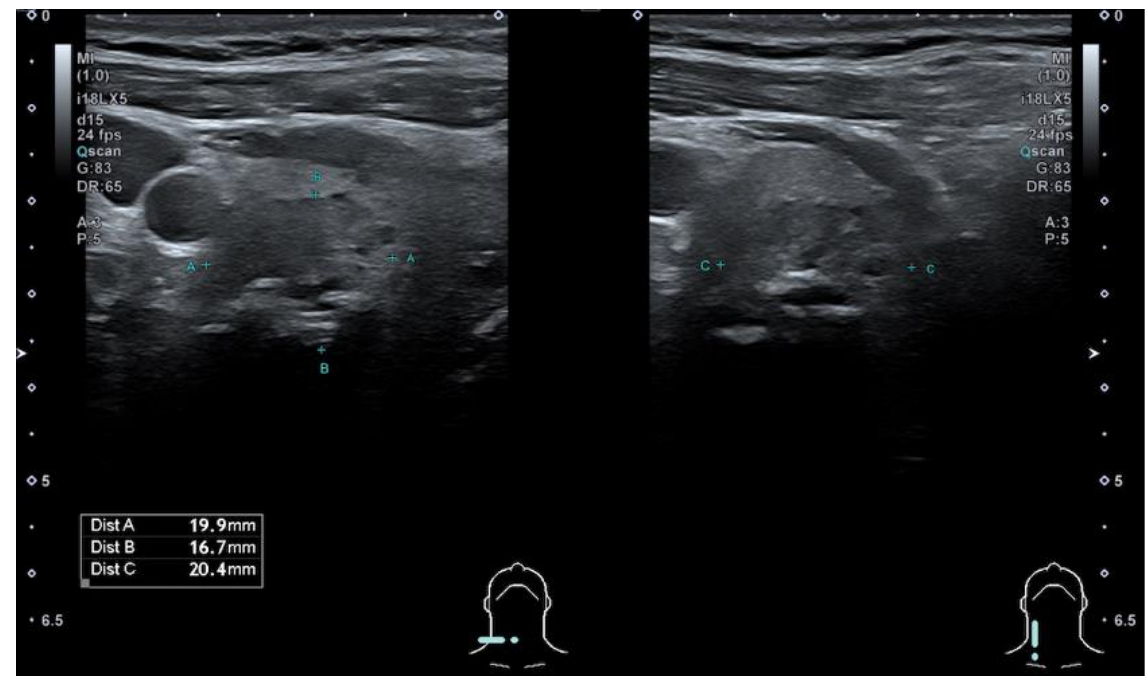
Figure 1. Hypoechogenic, ovoid, smooth, non-homogeneous solid thyroid nodule with cystic component and macrocalcification in its structure — categorized as TIRADS 3 by modified Kwak et al. (L-TIRADS), TIRADS 4 by European and Korean TIRADS, TIRADS 5 (5 points) by ACR TIRADS systems. FNA results — Bethesda 2 (benign).